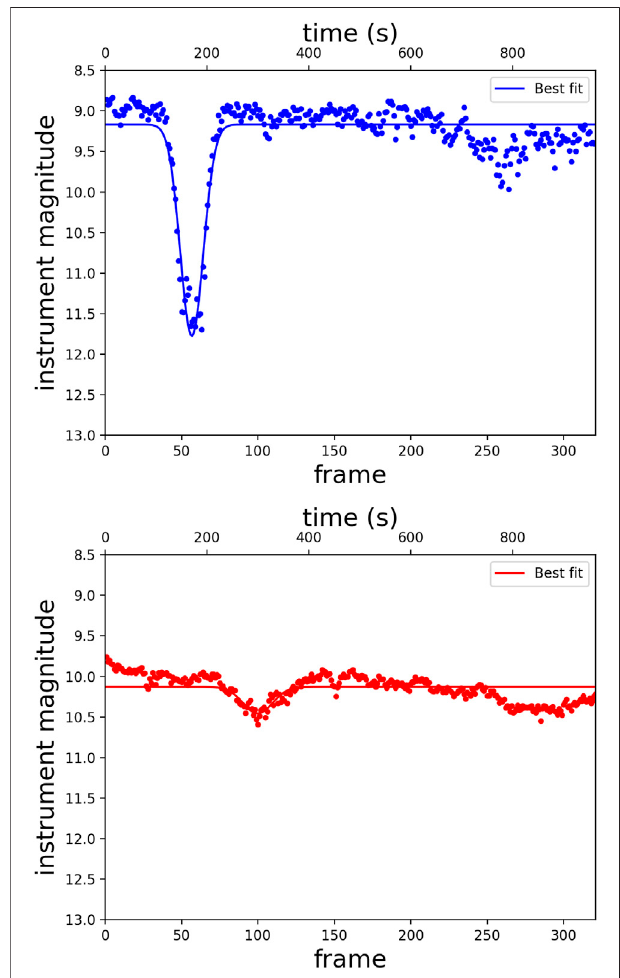
FIGURE 10 | Light curve of the eclipsing white dwarf ZTFJ0220 + 2,141 taken in February 2020 ( top ). Multiple light curves were taken in both red and blue channels; thisexamplelight curve isfrom the blue channel. AGaussian fi t was applied to the eclipse with no de-trending applied to the data. 340 3-s exposures were taken to capture the ∼ 90 s eclipse duration. Bottom shows a characteristic light curve of the cataclysmic variable NZ Boo from data taken in June 2020. Multiple light curves were taken in both red and blue channels; this example lightcurve is from the red channel. A Gaussian fi t was applied to the eclipse. The estimated eclipse duration is 4 min. These light curves demonstrate the high cadence observations possible with ‘ Alopeke and